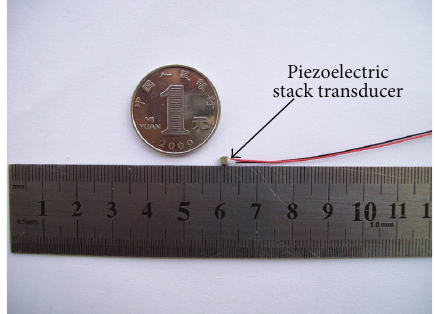
Figure 10: Photograph of the piezostack transducer.